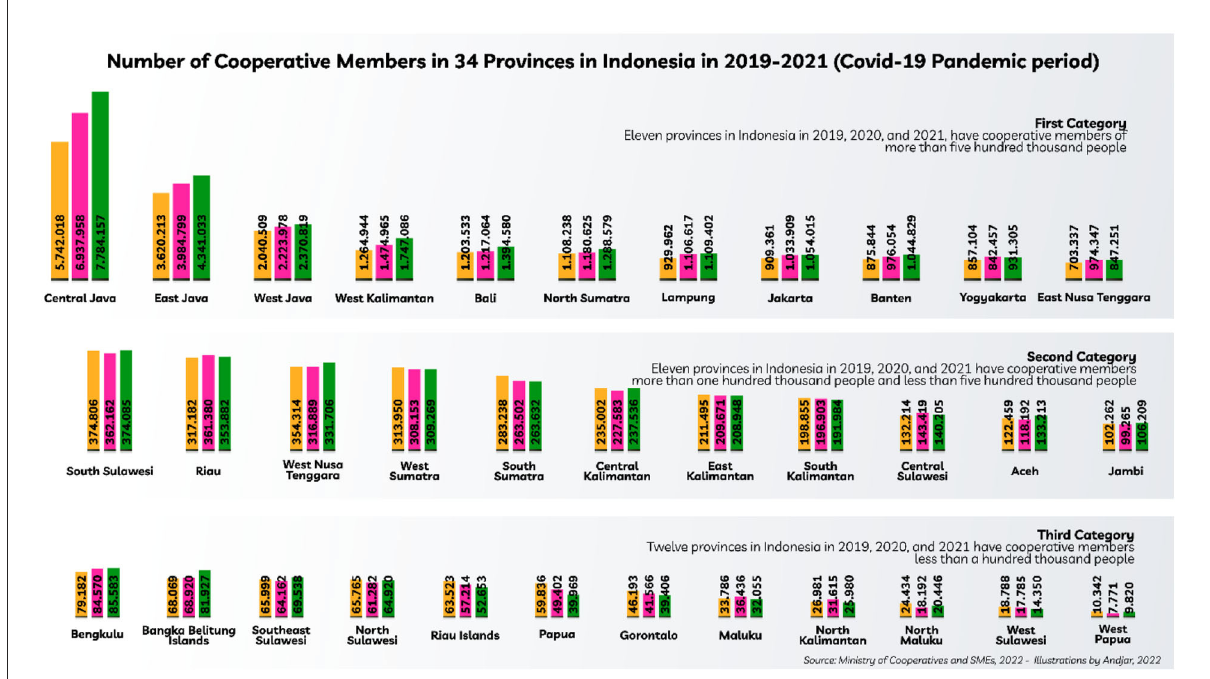
FIGURE3 Total of cooperative members in 34 provinces in Indonesia in 2019–2021 (COVID-19 pandemic period).